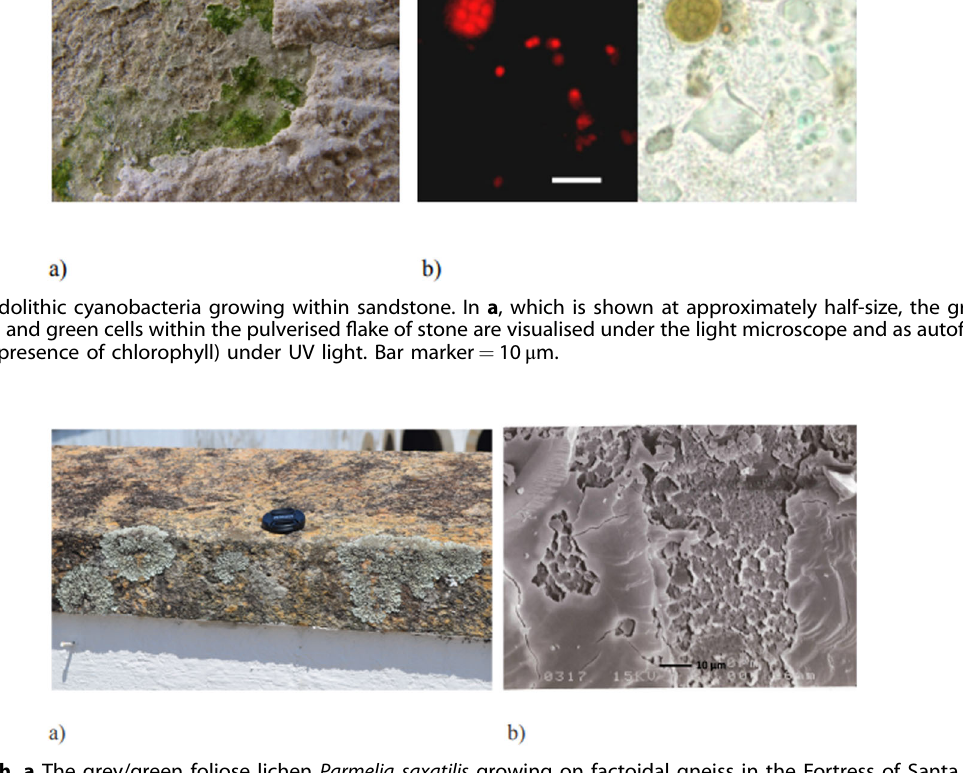
Fig. 5 Lichen growth. a The grey/green foliose lichen Parmelia saxatilis growing on factoidal gneiss in the Fortress of Santa Cruz da Barra, Niteroi, Brazil (size indicated by the lens cap), and b the etching beneath it, seen by scanning electron microscopy (bar marker 10 μ